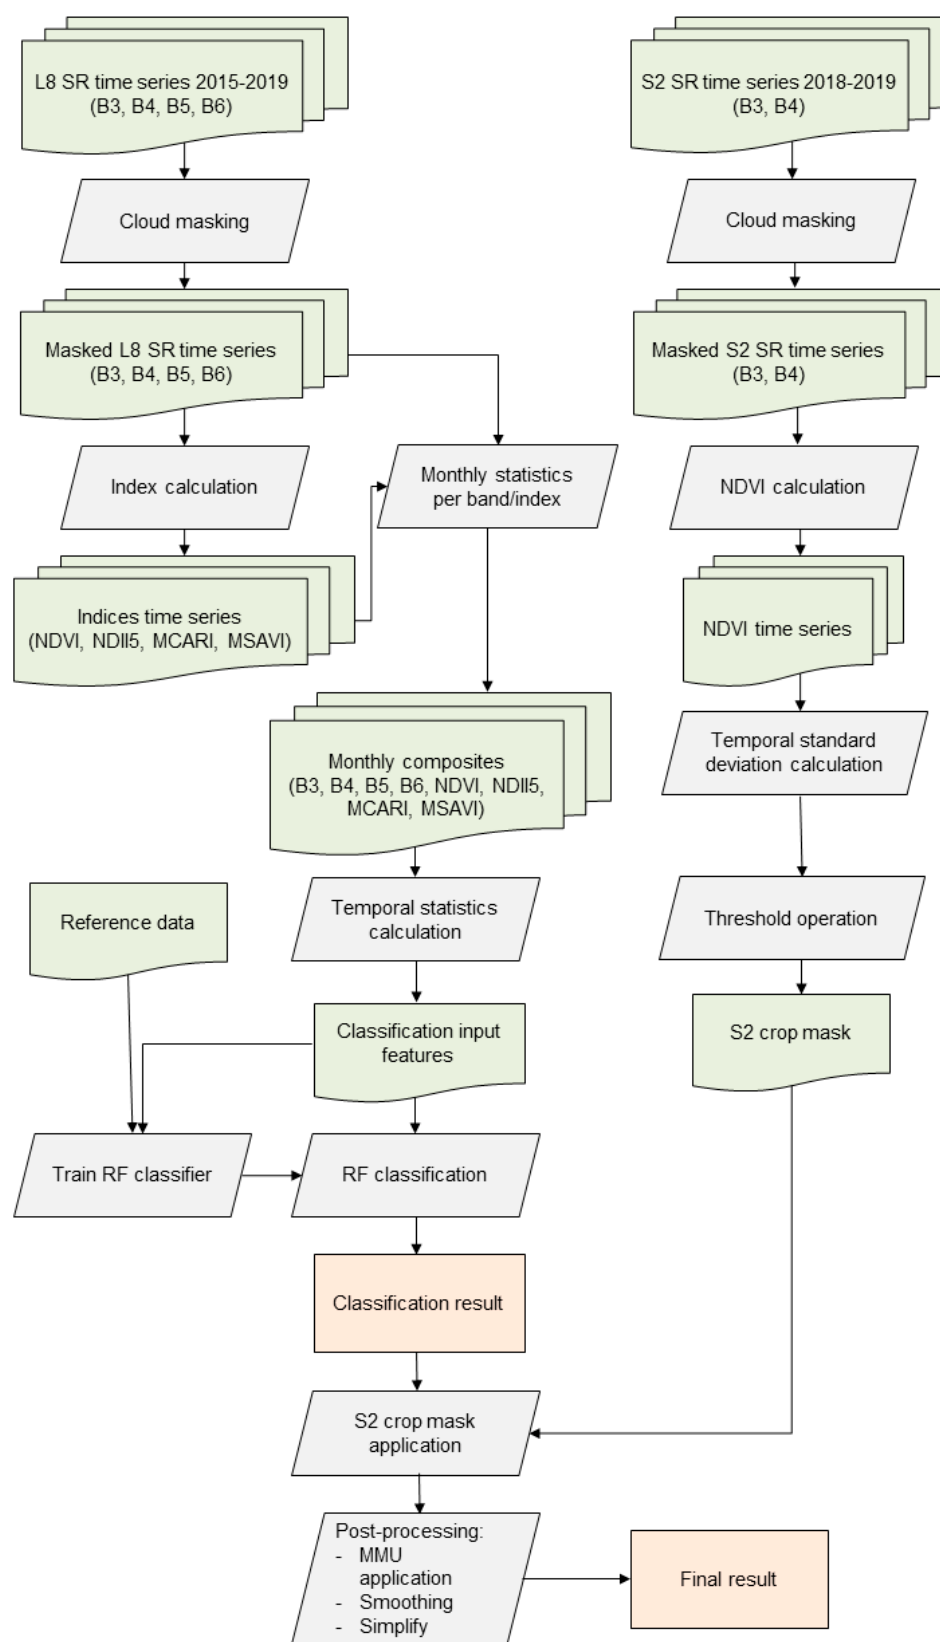
Figure 4. Workflow diagram of the applied mapping approach.